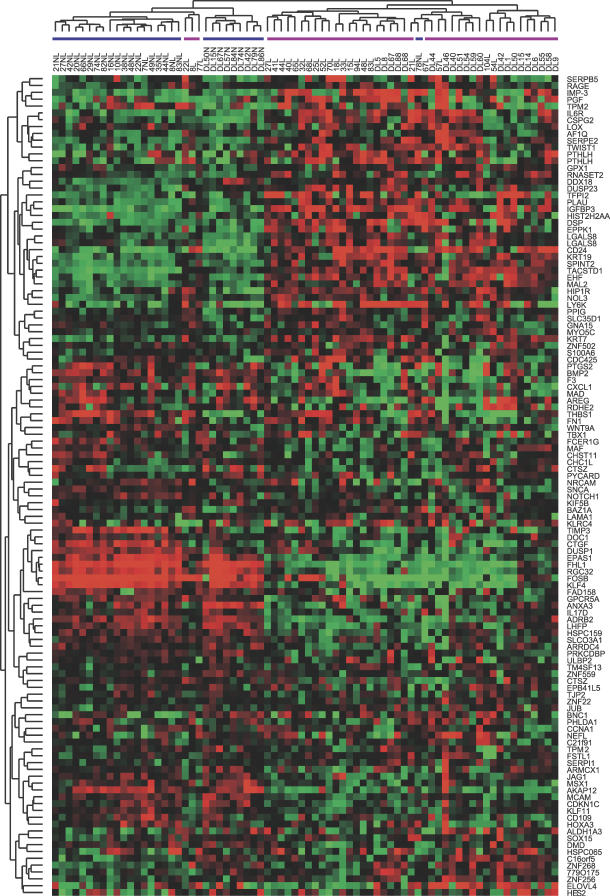
Complete-Linkage Cluster Analysis of 5-Aza-Induced Methylation Candidates in NSCLC and Normal Lung TissuesPanel included 46 primary NSCLC samples and 29 counterpart normal lung tissues. Arrays are median-centered and genes are mean centered and colored as in Figure 4. Blue bar indicates normal lung; purple bar indicates tumor tissue. The 5-aza induction gene set clearly distinguishes cancer from normal. Most genes are expressed at higher levels in normal tissues, although not all.